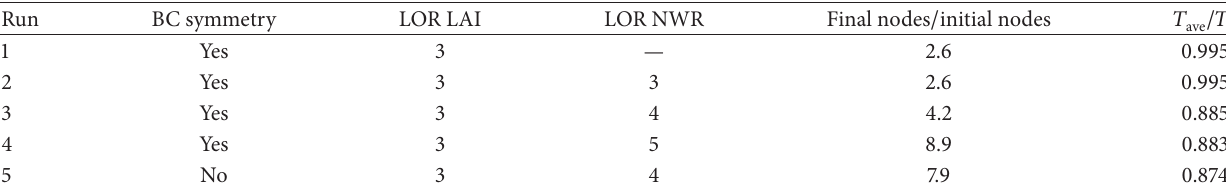
Table 4: Sensitivity analysis: test matrix.